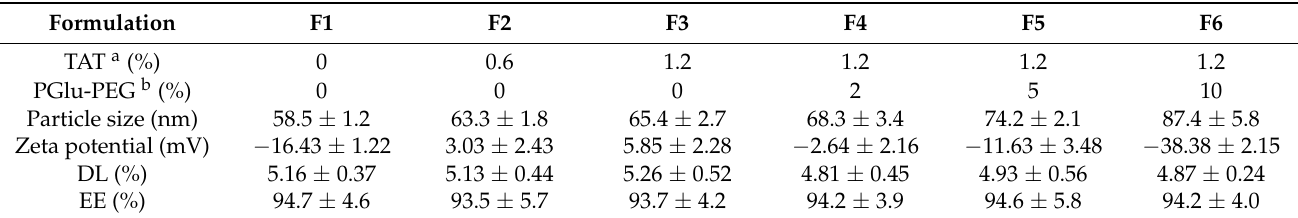
Table 1. Characterization of DSF-loaded nanoparticles with different modifications ( n =